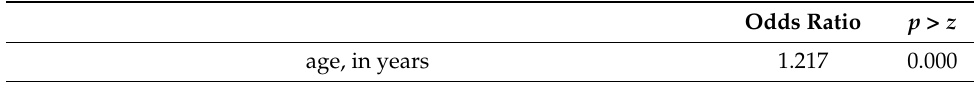
Table 3. Non-affiliation—fixed effects logistic regression